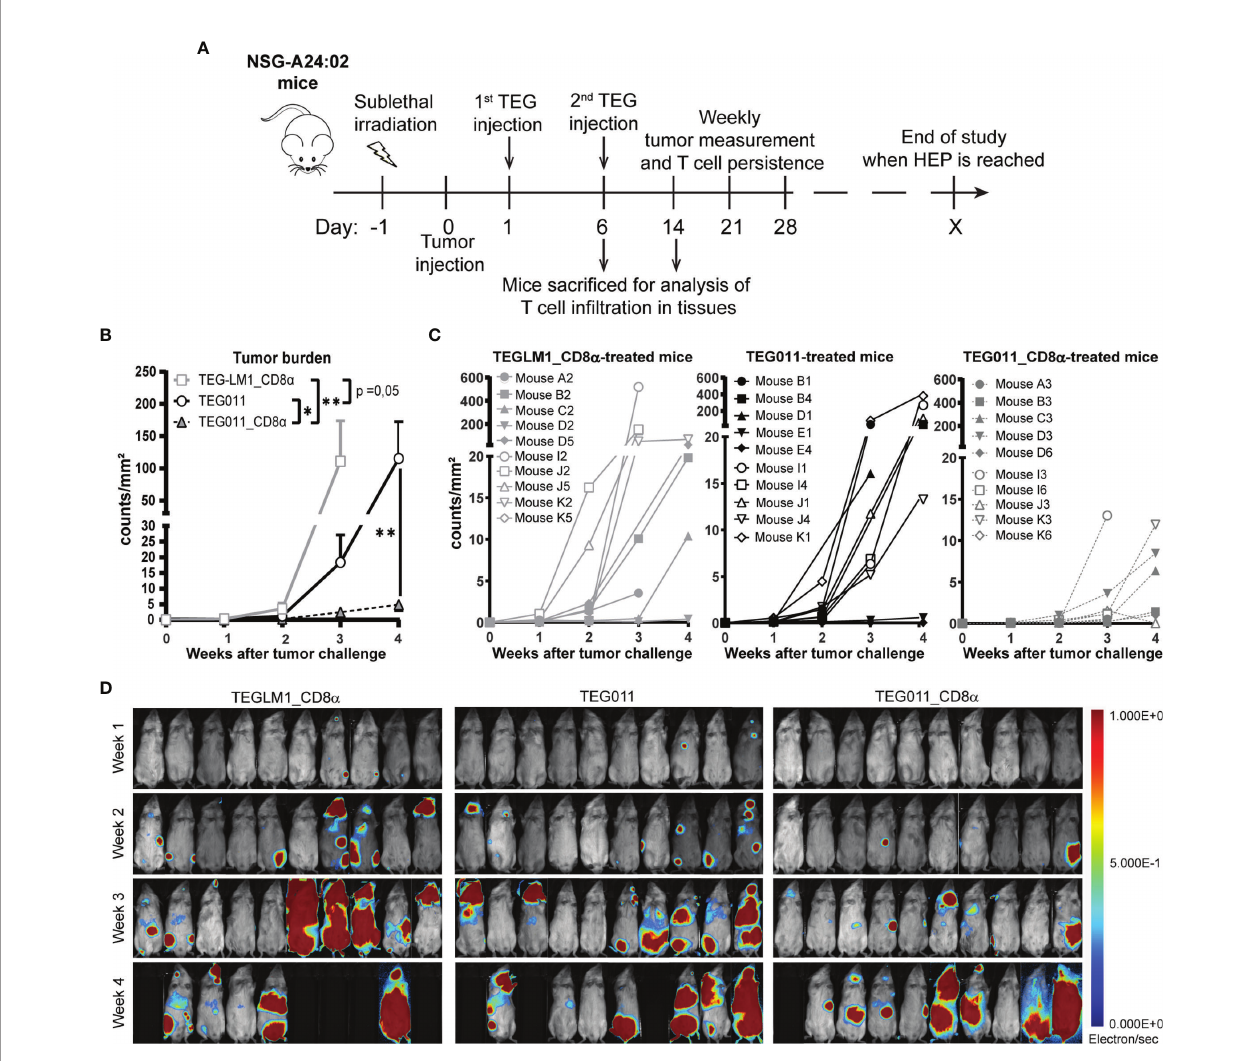
FIGURE 2 | TEG011_CD8 a improves in vivo tumor control against HLA-A*24:02 + tumor cells. (A) Schematic overview of the in vivo experiment for NSG-A24:02 tumor-bearing mice. Irradiated mice were intravenously injected with K562-HLA*A24:02-luciferase tumor cells on day 0 followed by two infusions of TEG011, TEG011_CD8 a , or TEGLM1_CD8 a mock cells on days 1 and 6. Mice were monitored regularly and sacri fi ced when the humane endpoint (HEP) was reached. (B) Tumor burden for K562-HLA*A24:02-luciferase was assessed in vivo measuring integrated signal density per total surface area (count/mm 2 ) by bioluminescence imaging (BLI) with the mouse abdomen facing up. Data are shown only up to week 3 for the TEGLM1_CD8 a mock-treated group (open light gray rectangle) due to subsequent mouse dropout >50%, while data for TEG011 (open black circle) and TEG011_CD8 a (open black triangle) are shown up to week 4. Data are shown as mean ± SEM of all mice per group (n = 10). Statistical signi fi cances were calculated by a mixed-effects model with repeated measure up to week 3 as comparison all treatment group (indicated next to legends) and only between TEG011 and TEG011_CD8 a group for week 4 (indicated on the graph); (*P < 0.05; **P < 0.01). (C) Tumor burden for individual mouse for each treatment group measured by integrated signal density per total surface area (count/mm 2 ) using BLI. (D) Tumor load for individual mouse was evaluated by bioluminescence imaging on week 1 to week 4 using Milabs Optical Imaging (OI) Acquisition and OI-Post processing software (version 2.0). Anesthetized mice were injected intraperitoneally with 25 mg/ml Beetle-luciferin (Promega). Calibrated units were calculated from integrated density of bioluminescence signal (electron/s) as shown by the right bar. The animals were imaged 10 min after luciferin injection. Black areas indicate loss of